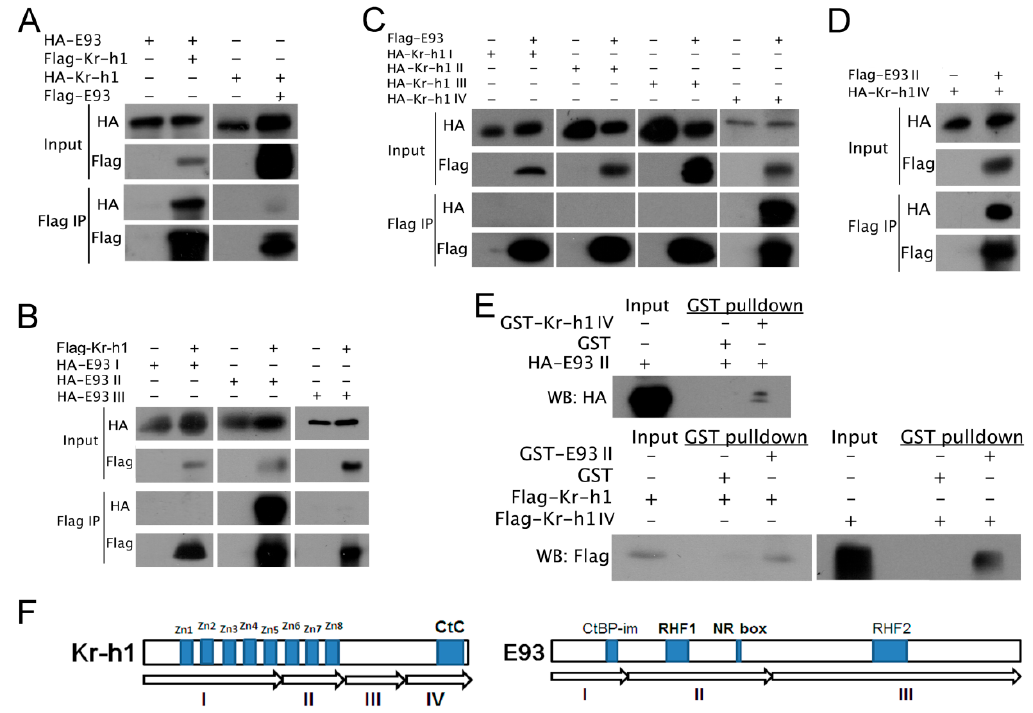
Figure 3. Interaction between E93 and Kr-h1. ( A ) E93 coimmunoprecipitated with Kr-h1. E93 and Kr-h1 were expressed separately and co-expressed. Immunoprecipitations from 293T cells were performed with anti-HA or anti-FLAG antibody, and HA / FLAG tag-fused E93 or Kr-h1 are shown as indicated. Beads with anti-FLAG antibody were used for Co-IP, and WB was used to check the Co-IP results. ( B ) Fragment II of E93 coimmunoprecipitated with Kr-h1. ( C ) WB results indicate that E93 interacts with fragment IV of Kr-h1. ( D ) WB results indicate that E93 II interacts with fragment IV of Kr-h1. The immunoprecipitation of ( B – D ) was performed as described in ( A ). ( E ) HA-E93 II, Flag-Kr-h1 and Flag-Kr-h1 IV were expressed in 293T cells, respectively, followed by GST fusion protein beads (GST-Kr-h1 IV-beads and GST-E93 II-beads) for pull down. The results of WB all showed that Kr-h1 IV and E93 II and E93 II and Kr-h1 interacted directly; ( F ) Schematic representation of Kr-h1 and E93 for identification of regions responsible for their protein–protein interaction. Fragment IV of Kr-h1 includes a recently identified C-terminal conserved (CtC domain) domain, fragment II of E93 contains domain RHF1 and NR box.